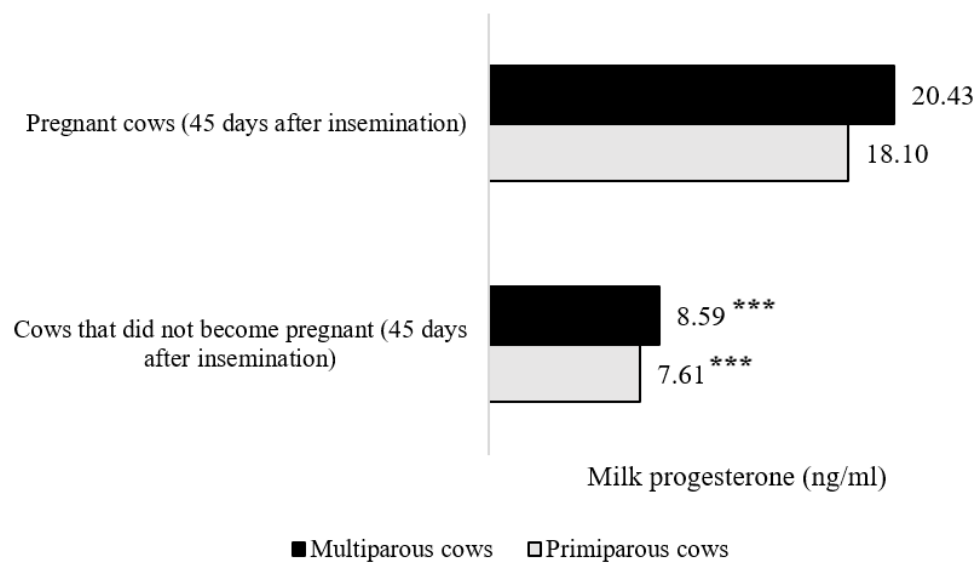
Figure 2. Changes in the level of milk progesterone (ng/mL) after insemination and during the pregnancy period (***—average values of progesterone in milk between did-become pregnant and did-not-become pregnant primiparous and multiparous cows with different superscripts differ significantly at p < 0.001). Table 2. The milk yield of cows in the postpartum period until insemination. AMY—average milk yield; HMY—highest milk yield. *—average values of AMY or HMY between primiparous and multiparous cows are statistically significantly di ff erent at p <